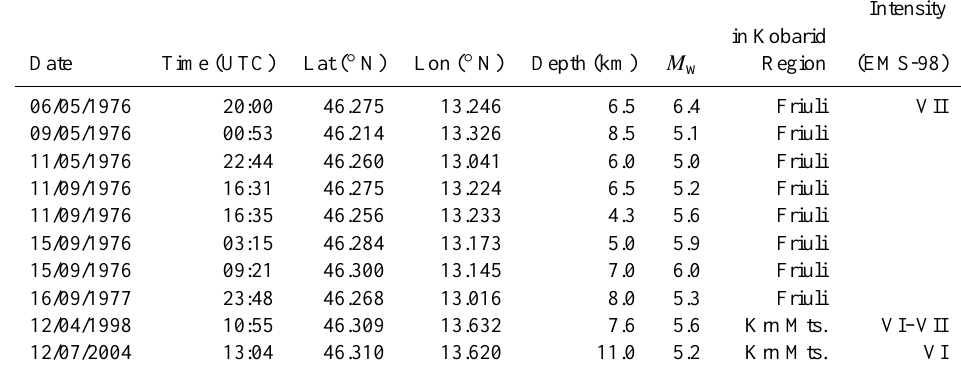
Table 1. Data for earthquakes with M w ≥ 5 . 0 in the vicinity of Kobarid (after Perniola et al., 2004; Zupanˇciˇc et al., 2001; Ceci´c et al., 2006).